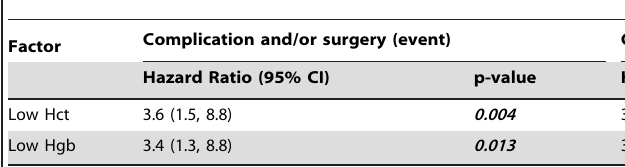
Table 2. Unadjusted time-to-event analysis.